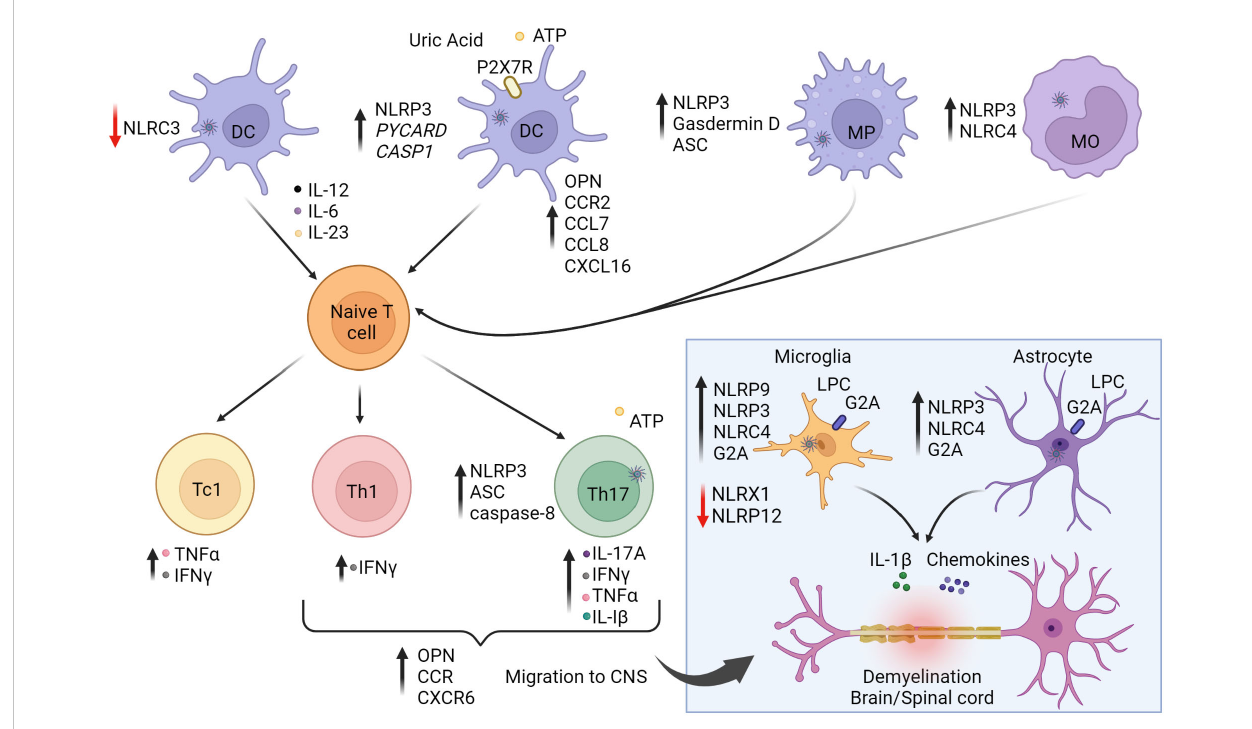
FIGURE 2 The role of in fl ammasomes in multiple sclerosis (MS) and experimental autoimmune encephalitis (EAE). The autoimmune response for MS is believed to begin in the periphery. Activation of NLRP3 and NLRC4 in fl ammasome pathways in antigen-presenting cells (APC) enhance stimulation and differentiation of pathogenic CD4 + Th1/Th17 and CD8 + Tc1 subsets. On the other hand, NLRC3 activation in dendritic cells (DC) is protective against disease by inhibiting DC maturation. Secretion of IL-1 b and IL-18 increase T cell expression of osteopontin (OPN), CCR2 (binding CCL7/8), and CXCR6 (binding CXCL16) to promote in fi ltration to the central nervous system (CNS). Upon activation and differentiation, CD4 + and CD8 + T cells, and B cells migrate to the CNS. In the CNS, peripheral DC, macrophages (MP), and monocytes (MO) further amplify in fl ammation. CNS resident cells such as microglia and astrocytes also promote in fl ammation. Lysophosphatidylcholine (LPC) activates NLRP3 and NLRC4, causing secretion of IL-1 b and chemokines, leading to further in fl ammation and demyelination. NLRP9 expression is increased in microglia. NLRX1 and NLRP12 serve to down- regulate neuroin fl ammation and provide protection against disease as indicated by the red arrows. Reduction of NLRX1 and NLRP12 can lead to exacerbated disease states. Purinergic receptor (P2X7R). The fi gure was prepared using Biorender software licensed to the UNC Lineberger Comprehensive Cancer